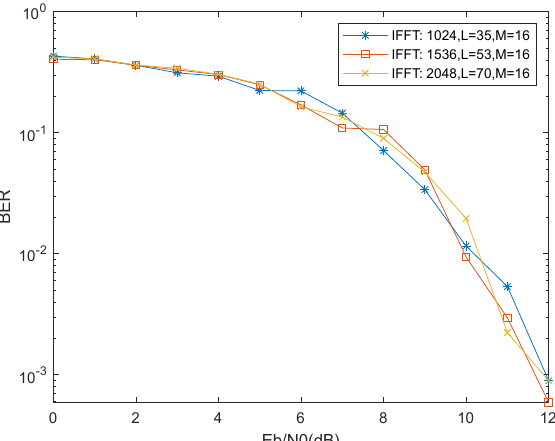
Figure 8. BER performance curves of the system with different number of IFFT points.